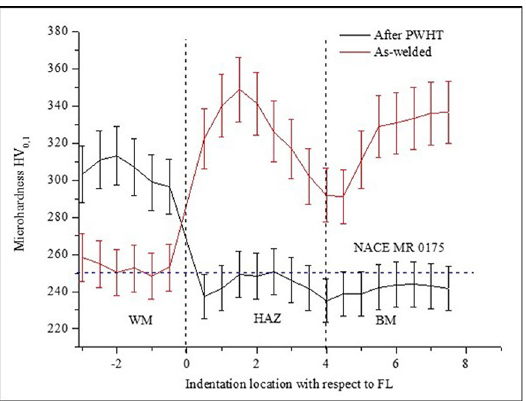
Figure 10. Mean Vickers microhardness profiles (NCS) of the WM, HAZ and BM regions.